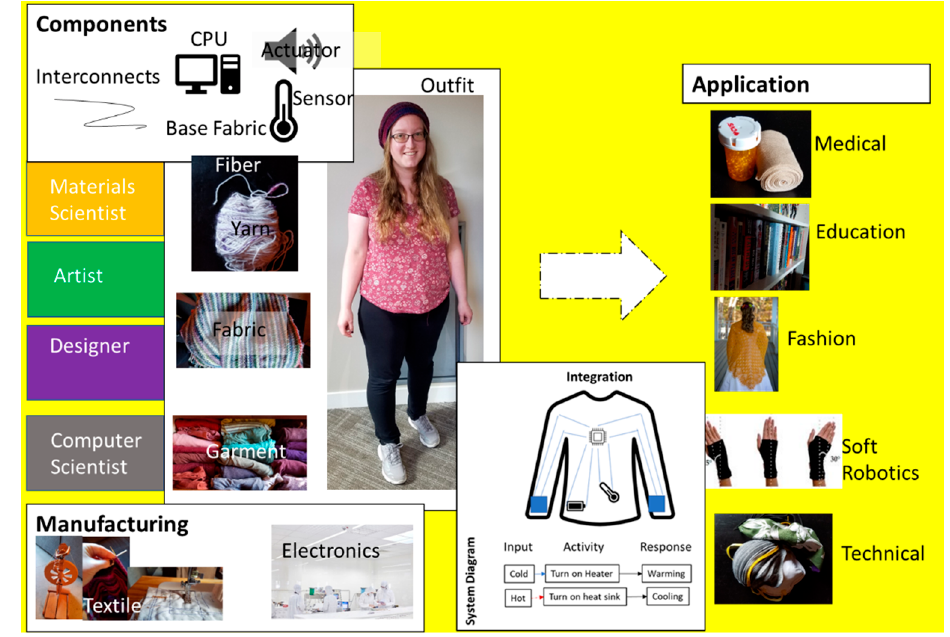
Figure 2. Overview of the current perspective on smart textile. Part of Figure adapted from [20,21].